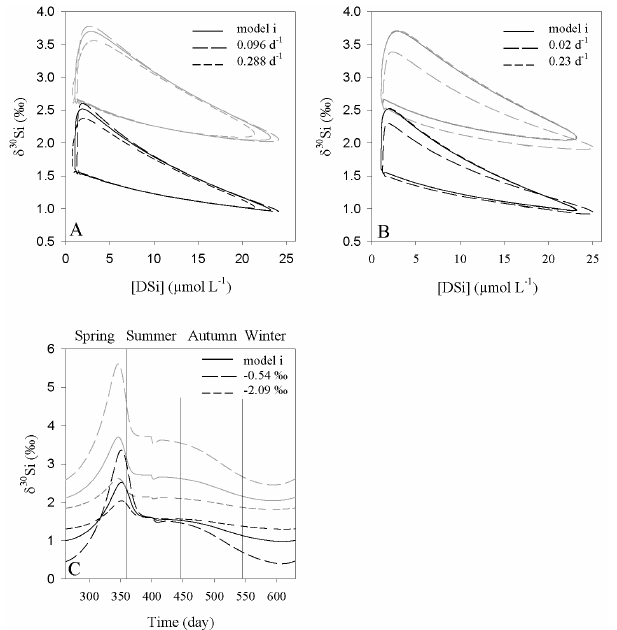
Fig. 11. Influence of the different (A) mortality rates on the δ 30 Si of DSi and BSi versus DSi concentration, (B) dissolution rates on the δ 30 Si of DSi and BSi versus DSi concentration and (C) variation of the δ 30 Si DSi and BSi versus time for different ε prod . Black: BSi, grey: DSi, solid line: initial run, dashed lines: values tested.